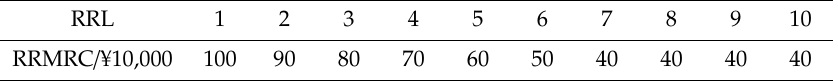
Table 4. The reserve risk maintenance resource costs (RRMRC) in the RTS-79 system. RRL